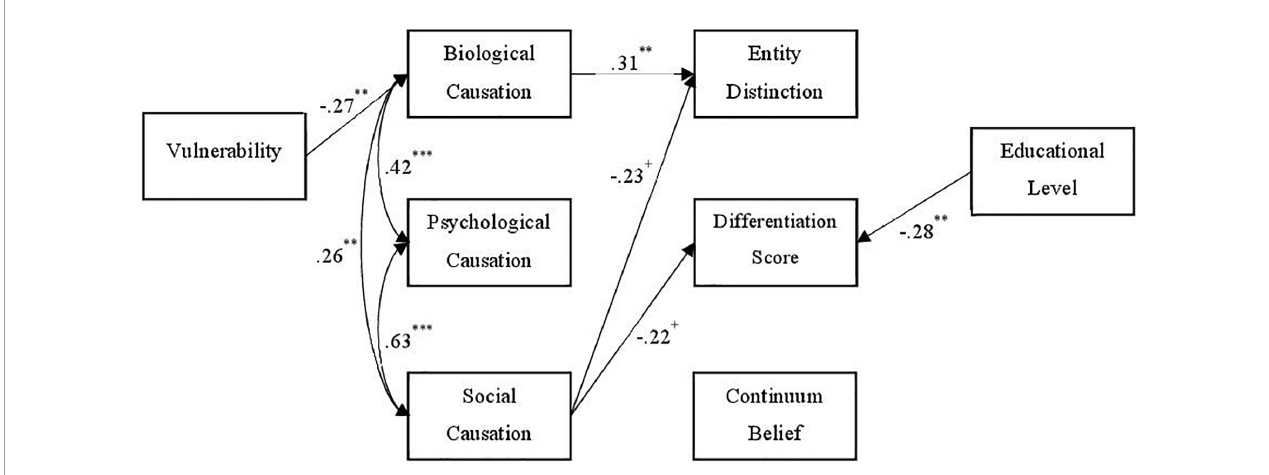
FIGURE2 Path model (no depression group). N = 92. Standardized path coefficients. Nonsignificant paths are not displayed. Coefficients with p < 0.10 were included due to the small study sample. + p < 0.10, ∗∗ p < 0.01, ∗∗∗ p <